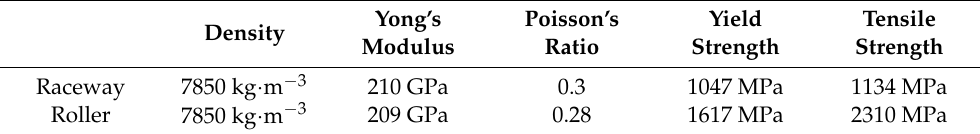
Figure 4. Curve of cyclic load Q with time. Table 2. The relation between the number of load cycles of roller raceway and the working time. t (h)